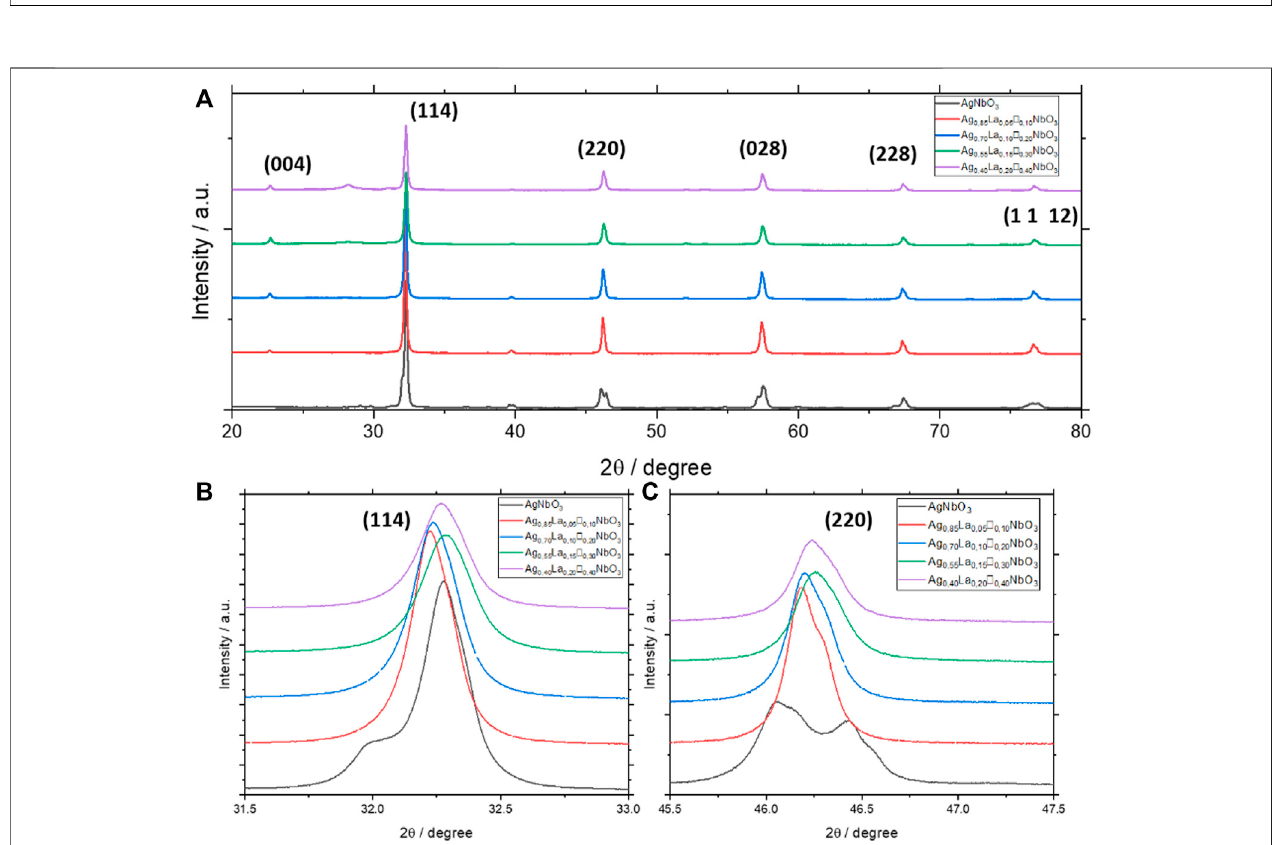
FIGURE 3 | (A – C) XRD patterns of Ag 1-3x La x □ 2x NbO 3 for different value of